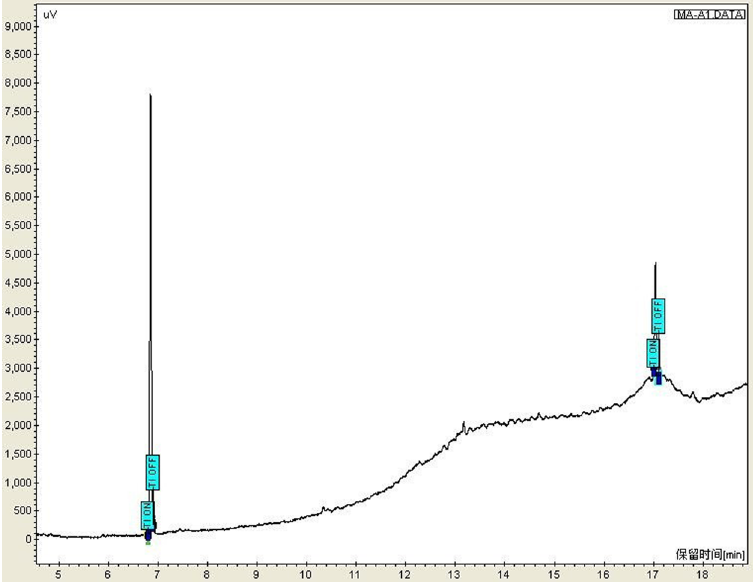
Figure 2. Chromatograms of extracts of MDMA and internal standard SKF 525A from blood samples (T R MDMA : 7.006 min; T R SKF525A : 17.016 min).